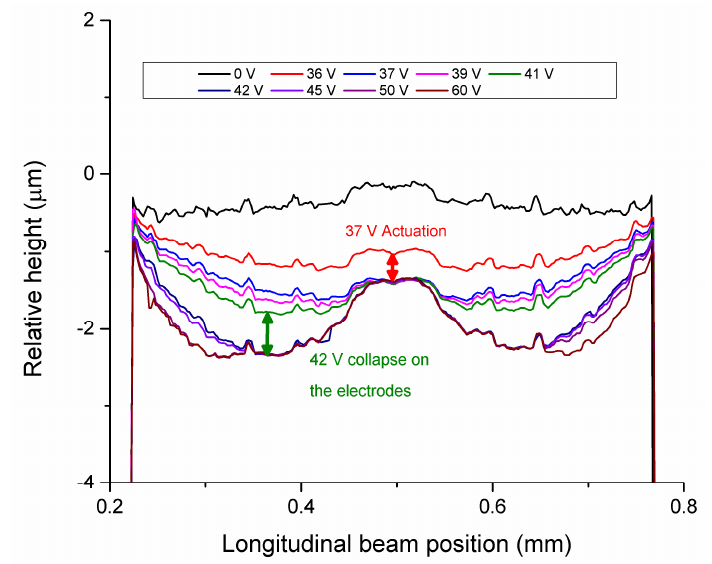
Figure 6. Evolution of the suspended beam shape at different (increasing) voltages for the RF-MEMS switch reported in Figure 5. The lines have been recorded with an optical profiler while biasing the switch.